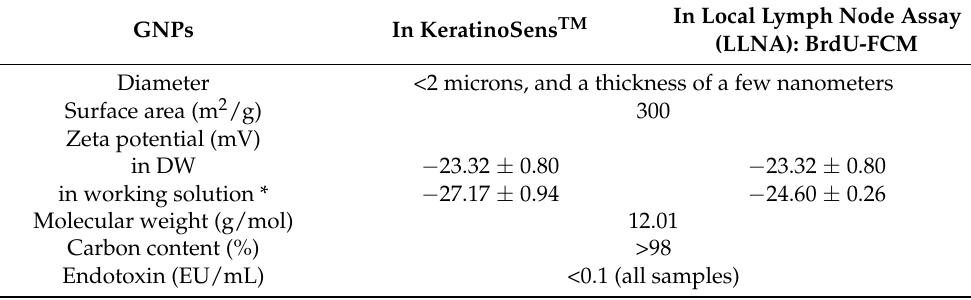
In Local Lymph Node Assay